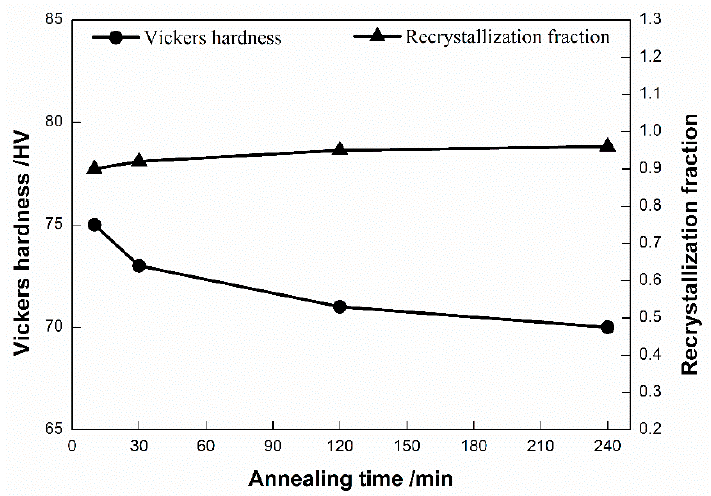
Figure 12. Vickers hardness values and recrystallization fractions under different times.